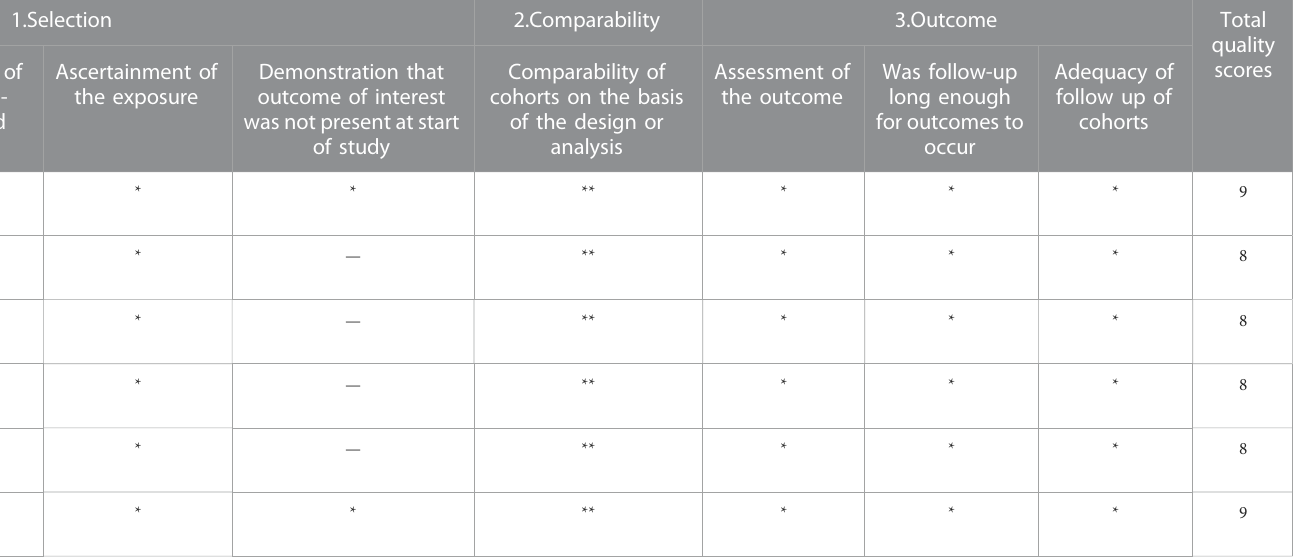
TABLE 3 The quality of cohort studies assessed via NOS.